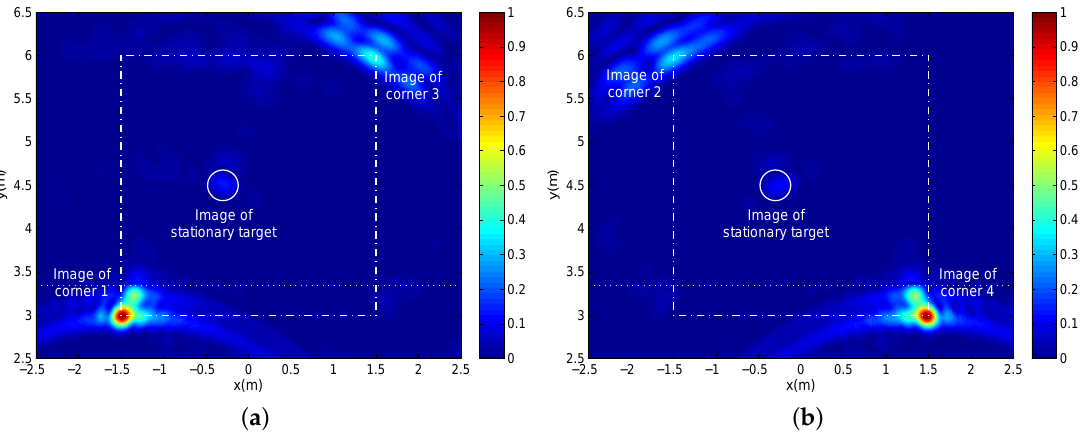
Figure 7. The single-location images corresponding to ( a ) Location A and ( b ) Location B, where the square dashed-dotted lines represent the preset wall layout, the circle represents the preset stationary target position and the dotted line represents the boundary of the near sub-scene and the far